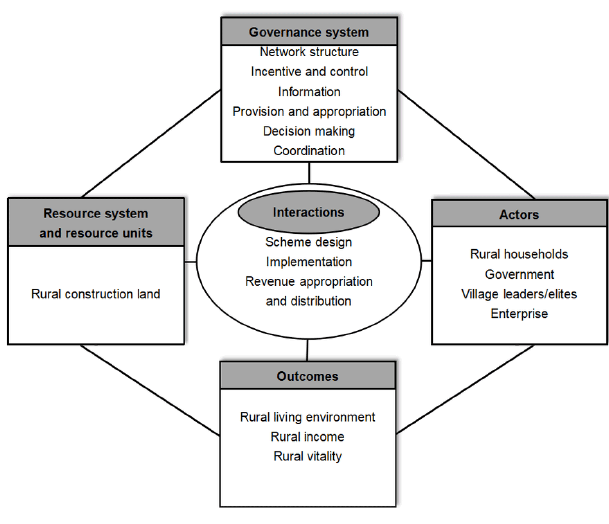
Fig. 1 . Social-ecological systems (SES) framework of rural